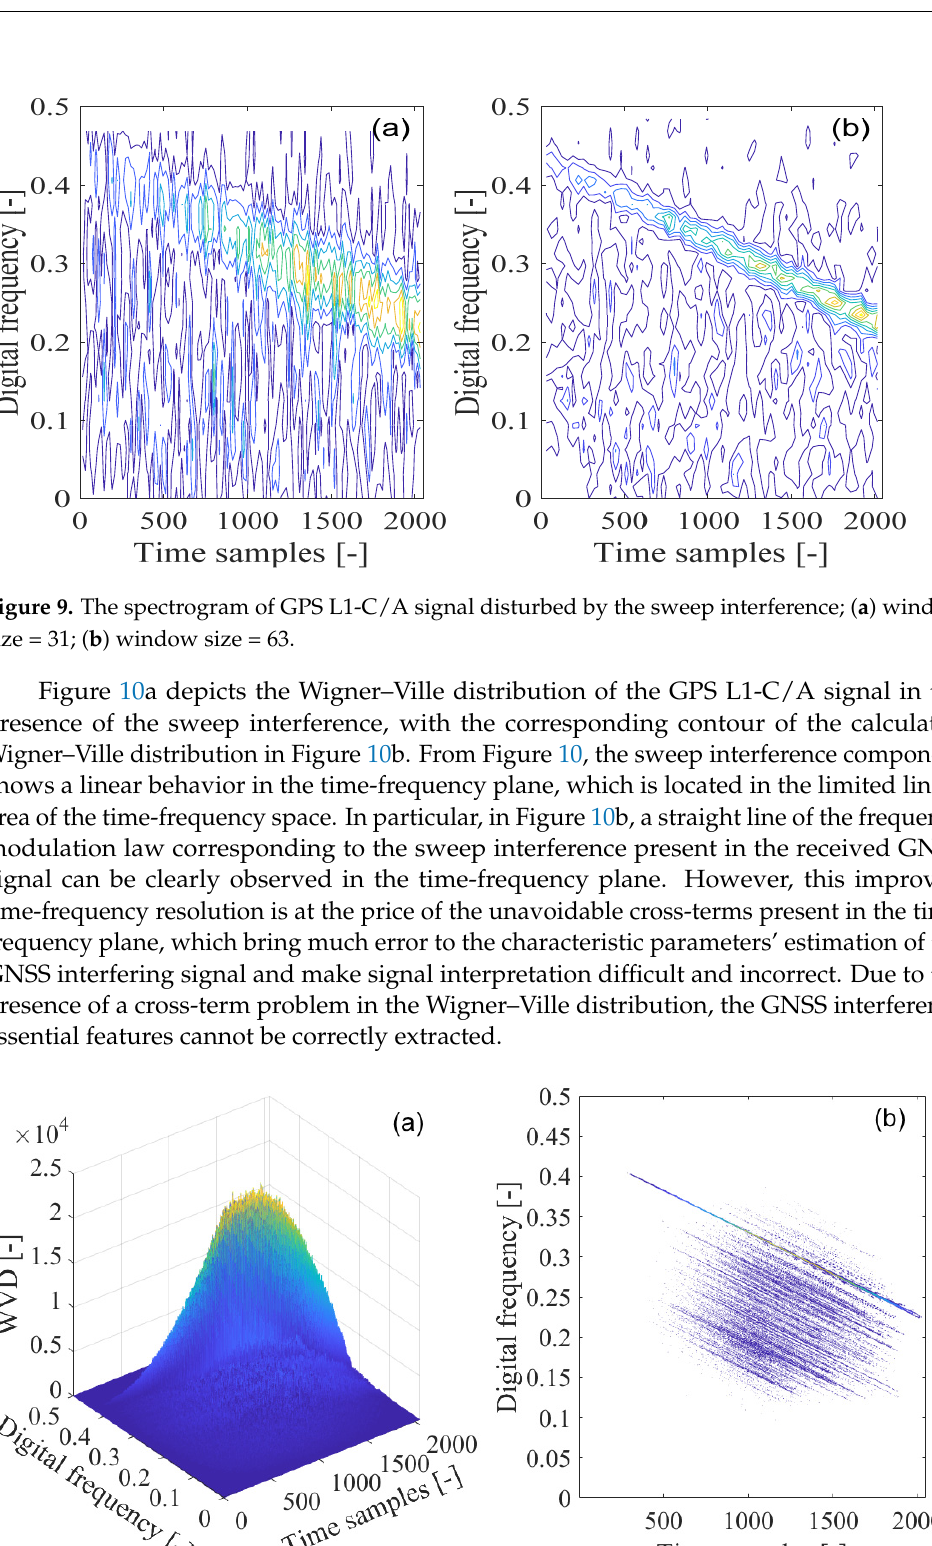
14 of 23 Table 1. Setup parameters in the GNSS interference detection test. Parameter Value Sampling frequency, 𝑓 (cid:3046) 24 MHz Intermediate frequency, 𝑓 (cid:3010)(cid:3007) 40.42 MHz Code length 1023 chips Sweep Period